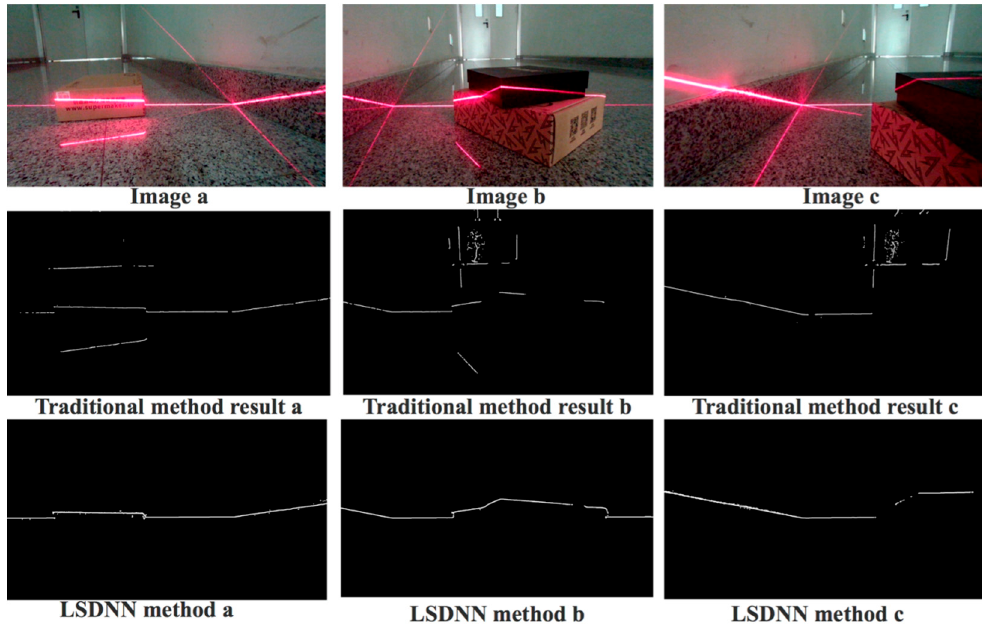
Figure 10. Detection and extraction result of laser stripe center.